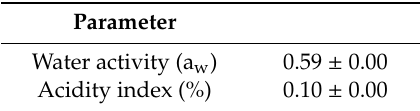
Table 3. Water activity and acidity index of teosinte